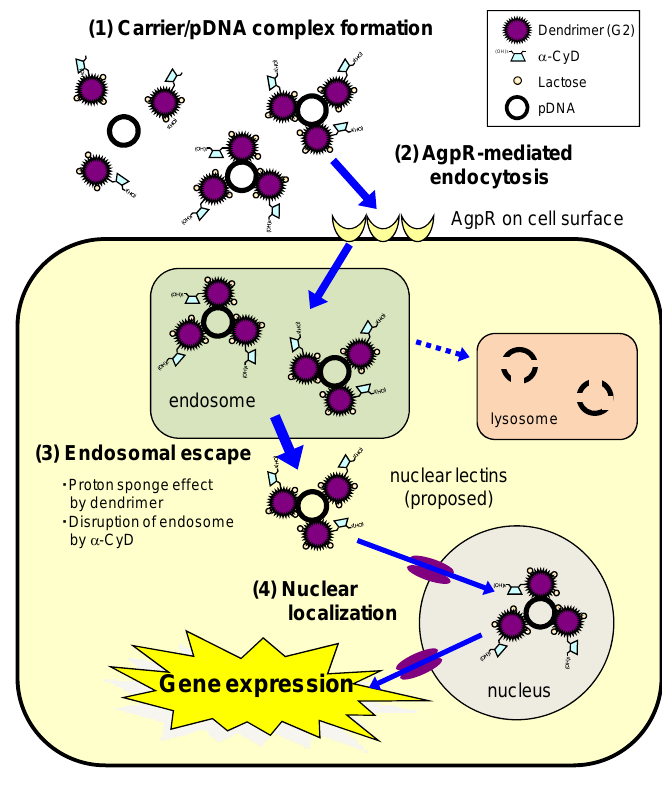
Figure 5. Proposed scheme for improved effects of gene transfer activity by Lac- α -CDE (G2,